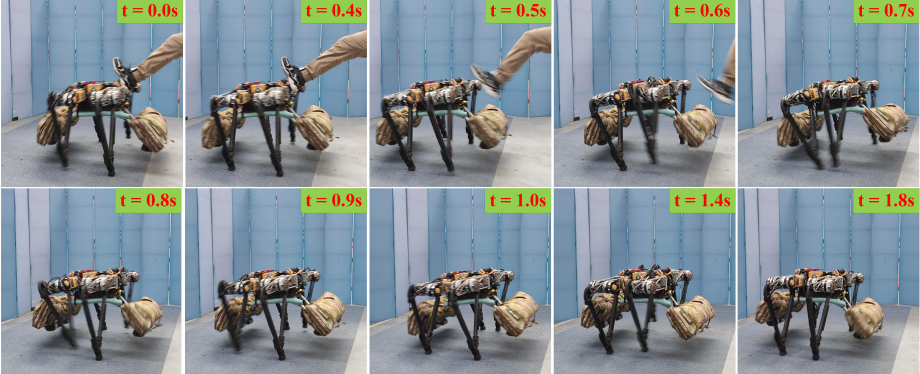
Figure 5. Snapshots of the disturbance recovery experiment.